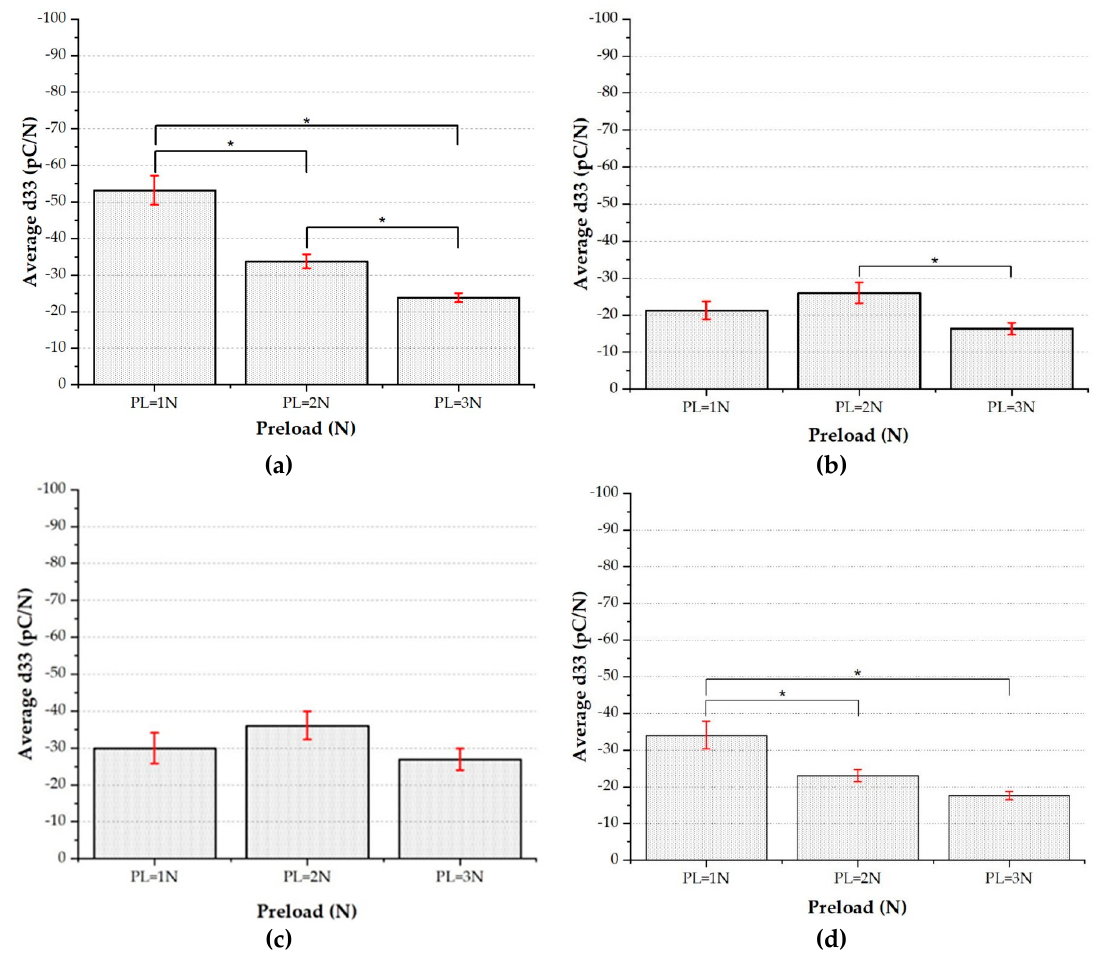
Figure 13. Average d 33 vs. Preload for four different categories: ( a ) Category 1 (palm left 2). ( b ) Category 2 (palm right 2). ( c ) Category 3 (palm right 1). ( d ) Category 4 (Michelangelo palm). One-way